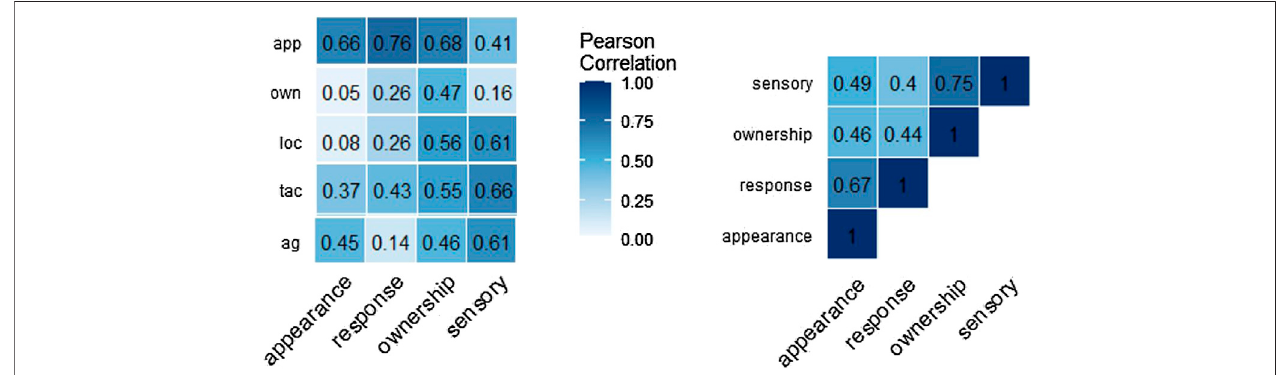
FIGURE 2 | Left: Correlation matrix between the previous questionnaire categories (abbreviated and along the vertical axis) and the new questionnaire categories (along the horizontal axis). Right: Correlation matrix between the new categories.